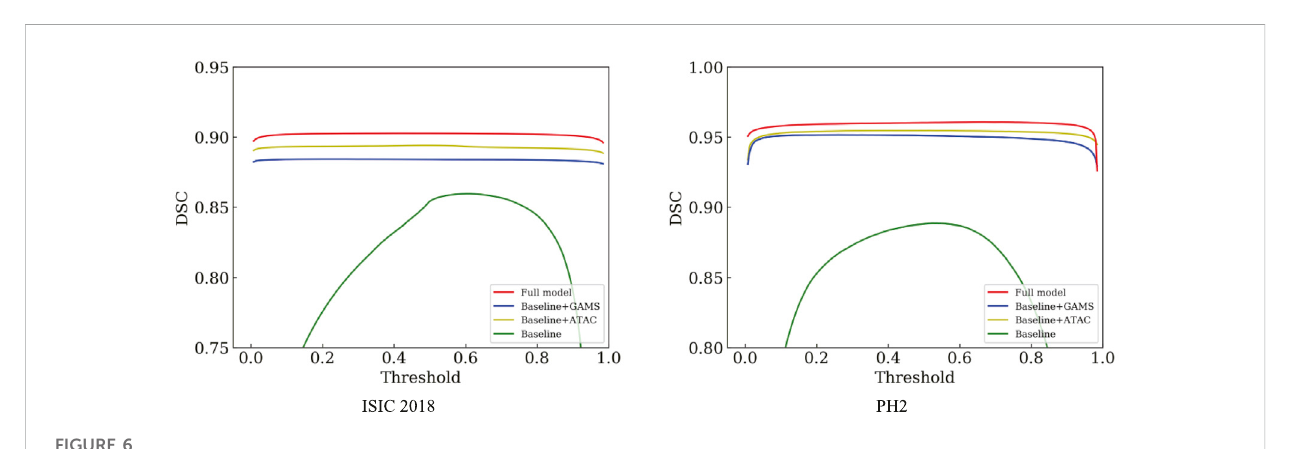
FIGURE 6 Comparison of the DSC curves under different thresholds on ISIC 2018 and